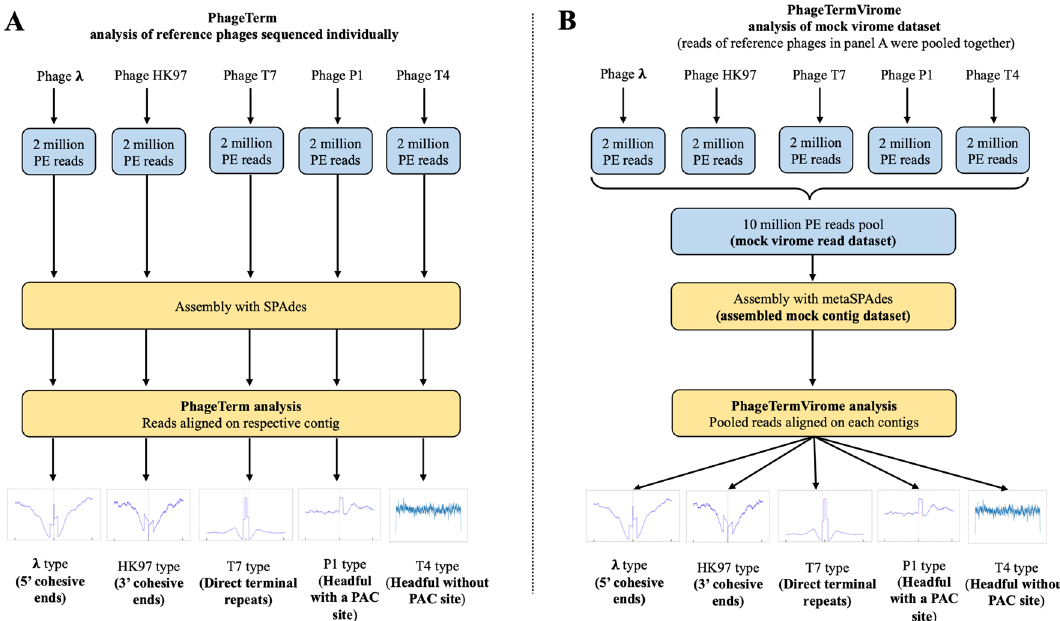
Figure 2. Comparison of results obtained with PhageTerm versus PhageTermVirome when using a mock virome dataset. ( A ) Individually sequenced phages, separately analyzed using PhageTerm previously confirmed the well-established packaging mechanism for each reference phage. ( B ) Reads of reference phages used in panel ( A ) were pooled to form the mock virome read dataset and were then assembled with metaSPAdes to generate the associated mock viral contig dataset. The pool of 10 million reads were mapped to the assembled contigs to obtain coverage values, statistics, termini positions, and packaging mechanism predictions for each